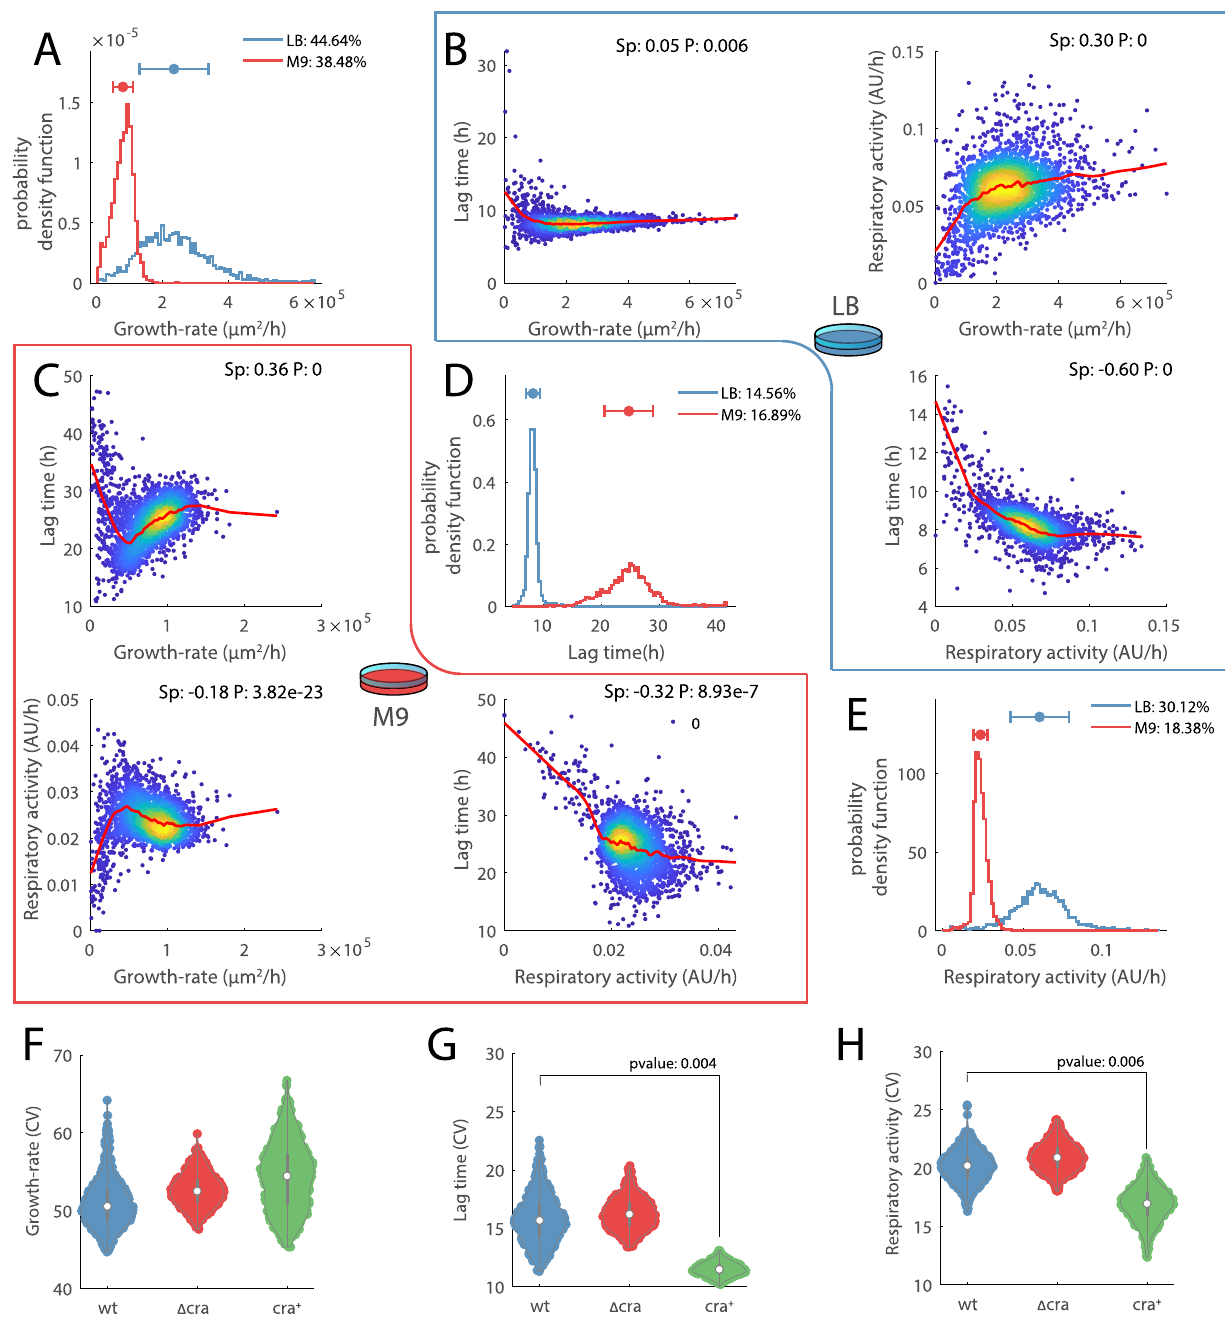
Fig. 2 Colony-to-colony variation. A , D , E Distribution of maximum growth rates, lag times, and respiratory rates, estimated for 5485 colonies of wild-type E. coli growing in LB (red) and glucose M9 (blue) agar plates (Supplementary Data 1). Estimates were derived from colonies grown independently in three different plates with LB and three plates with M9 glucose solid media. B , C 2D density plots in which each dot represents one colony and the red line a locally weighted smoothed average (i.e., lowess function). On the upper right corner of each panel, we reported the Spearman correlation (Sp) and corresponding p value ( P , testing the hypothesis of no correlation against the alternative hypothesis of a nonzero correlation using the Spearman ’ s Rho test) between growth rate, lag time and respiratory activity in LB ( B ) and glucose M9 ( C ). F , G , H Distribution of CVs for growth parameters estimated from 1000 random selections of 400 colonies from wild-type (blue), Δ cra (red), and cra + mutant (green) (Fig. S4). Reported signi fi cance was estimated from a two-tailed t